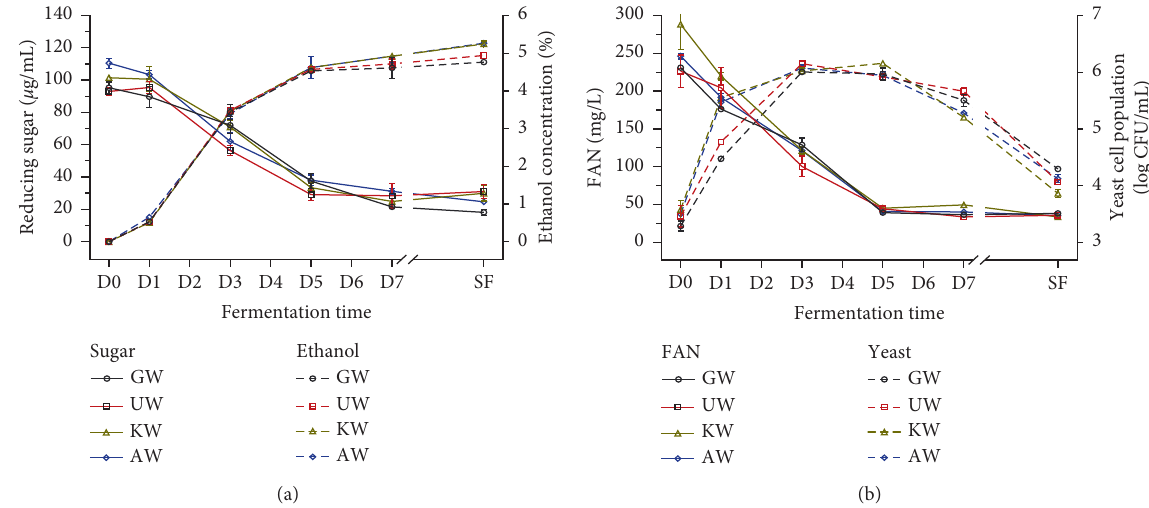
Figure 1: Changes of (a) reducing sugar and ethanol concentration and (b) free amino nitrogen (FAN) contents and yeast cell population among the wort samples during the fermentation. Four wort samples (GW, UW, KW, and AW) were made of four different wheat malts as the main ingredients (German, USA, Keumkang , and Anzunbaengi malt, respectively). Axis of abscissas points represents beginning for fermentation (D0), fermentation time of 1–7 days (D1–D7), and end of secondary fermentation (SF).